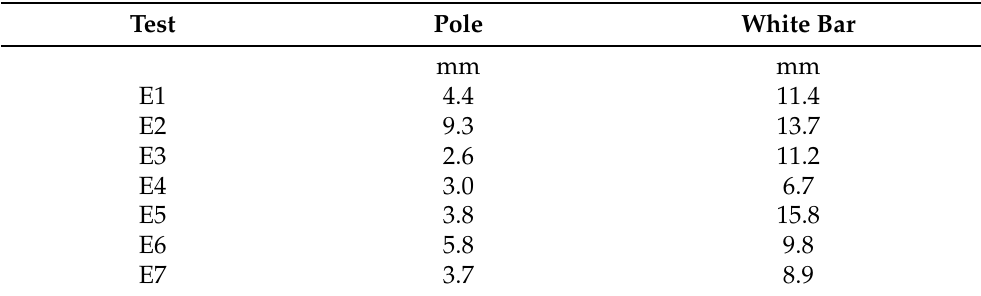
Table 5. MAE in mm between filtered and benchmark lengths estimated from the entire sequence of RGB and NIR images for the pole and white bar.